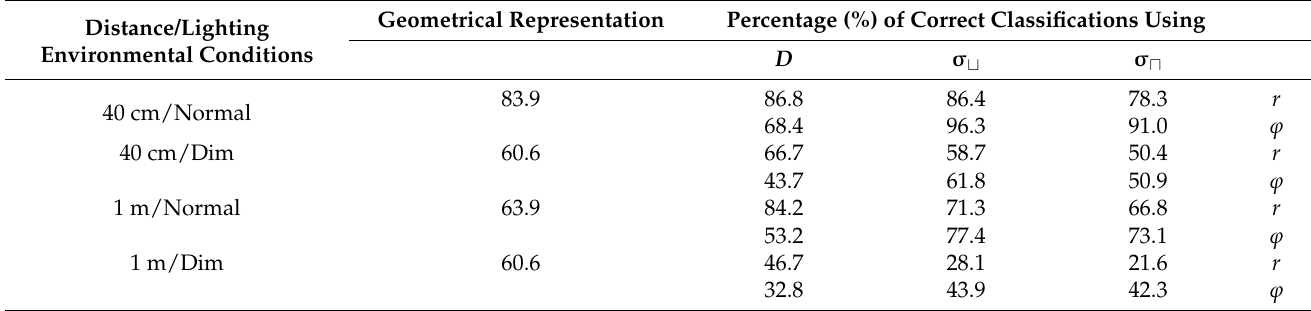
Table 1. Results by the GbCvector classifier with separate vectors r and ϕ for four different environmental conditions. Geometrical Representation Percentage (%) of Correct Classifications Using Distance/Lighting Environmental Conditions D σ (cid:116) σ (cid:117) 83.9 86.8 40 cm/Normal 40 cm/Dim 1 m/Normal